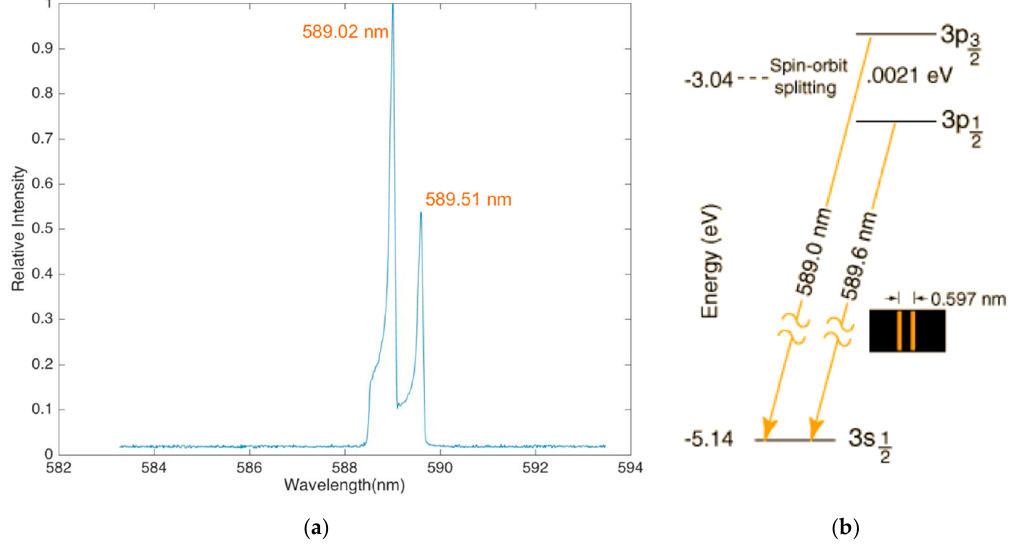
Figure 9. ( a ) Observed two peaks and ( b ) sodium D line doublet (courtesy of HyperPhysics from Georgia State University [23]).